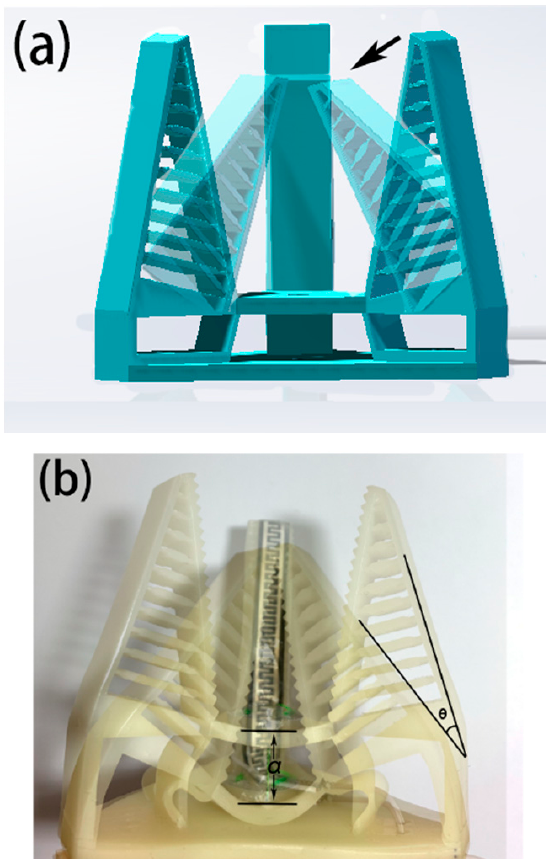
Figure 7. Schematic diagram of the angular displacement of the finger end θ and the length of the pulling wire movement. ( a ) shows the displacement schematic in the modeling and ( b ) shows the physical drawing, where α is the change in displacement length of the pulling wire and θ is the change in angular displacement of the end of the finger. Next, the soft gripper’s force feedback system was investigated. The values of the gripping force collected by the sensor were inputted to the Arduino Uno controller and can be read through the serial monitor or external display at the current moment. The relationship between the measured force values and the variation of the displacement of the pulling wire was investigated in this experiment. A hollow cylinder 3D-printed using ABS material was used as the gripped object with a weight of 200 g (diameter: 50 mm, height: 70 mm), as shown in Figure